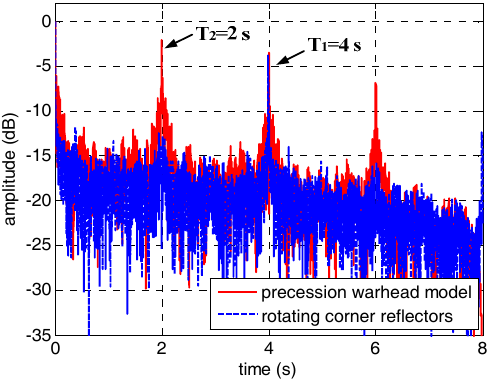
Figure 7. The estimation results of micro-motion period based on autocorrelation.